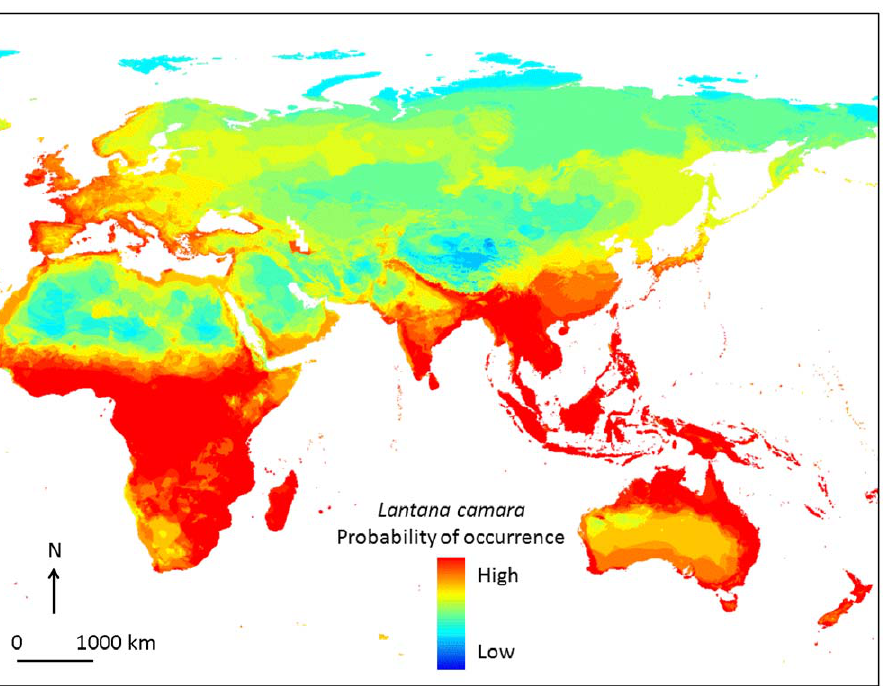
Figure 4. Bioclimatic niche model of Lantana camara based on point data stored in the Global Biodiversity Information Facility and generated by automated openModeller algorithm. The point data are derived by searching the Global Biodiversity Information Facility [90] for Lantana camara , which has the following recognised synonyms: Lantana aculeata , Lantana tiliifolia , Lantana camara var. nivea, Lantana camara var. mista, Lantana camara var. mutabilis, Lantana camara var. hybrida, Lantana camara var. flava, Lantana camara var. aculeata, Lantana camara var. sanguinea. The openModeller niche model uses WorldClim global climate layers (climate grids) with a spatial resolution of one square kilometre [91].